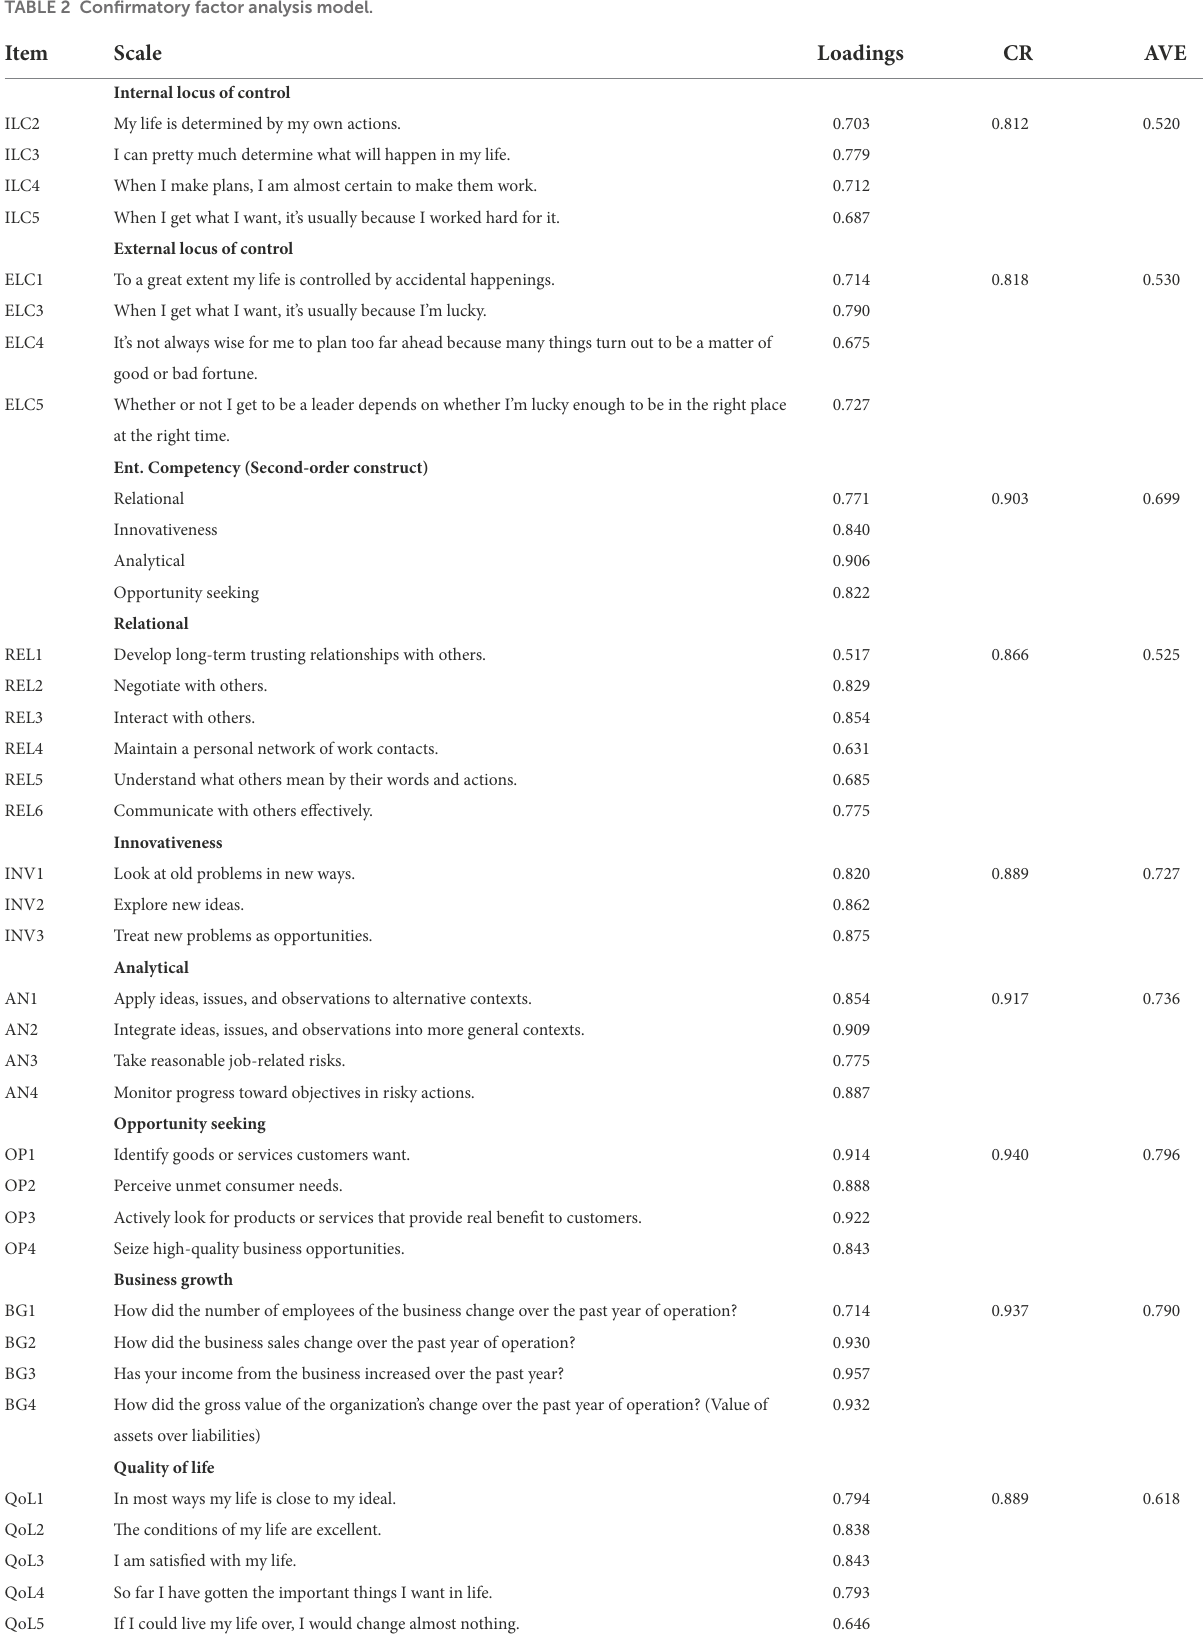
TABLE 2 Confirmatory factor analysis